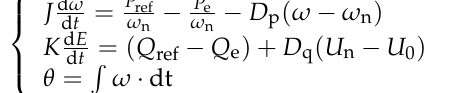
load through their respective voltage source converters. The DC side is replaced by a volt- age source u dci ( i = 1, 2, 3), and the AC side output realizes power transmission through the line impedance and switches after filtering out the high harmonics through the LC filter.